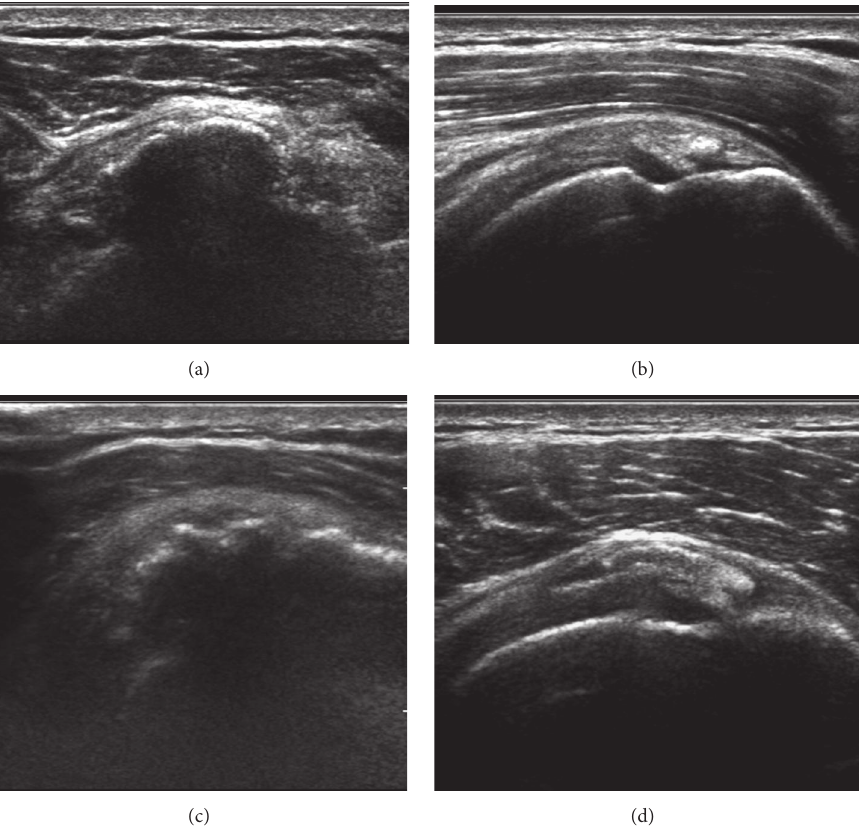
Figure 4: Ultrasound appearance of calcific tendinopathy. (a) Arc morphology: echogenic arc of calcification with deep acoustic shadowing. (b) Nodular morphology: single echogenic focus of calcification without acoustic shadowing. (c) and (d) Fragmented morphology: two or more echogenic foci of calcification with (image (c)) or without (image (d)) acoustic